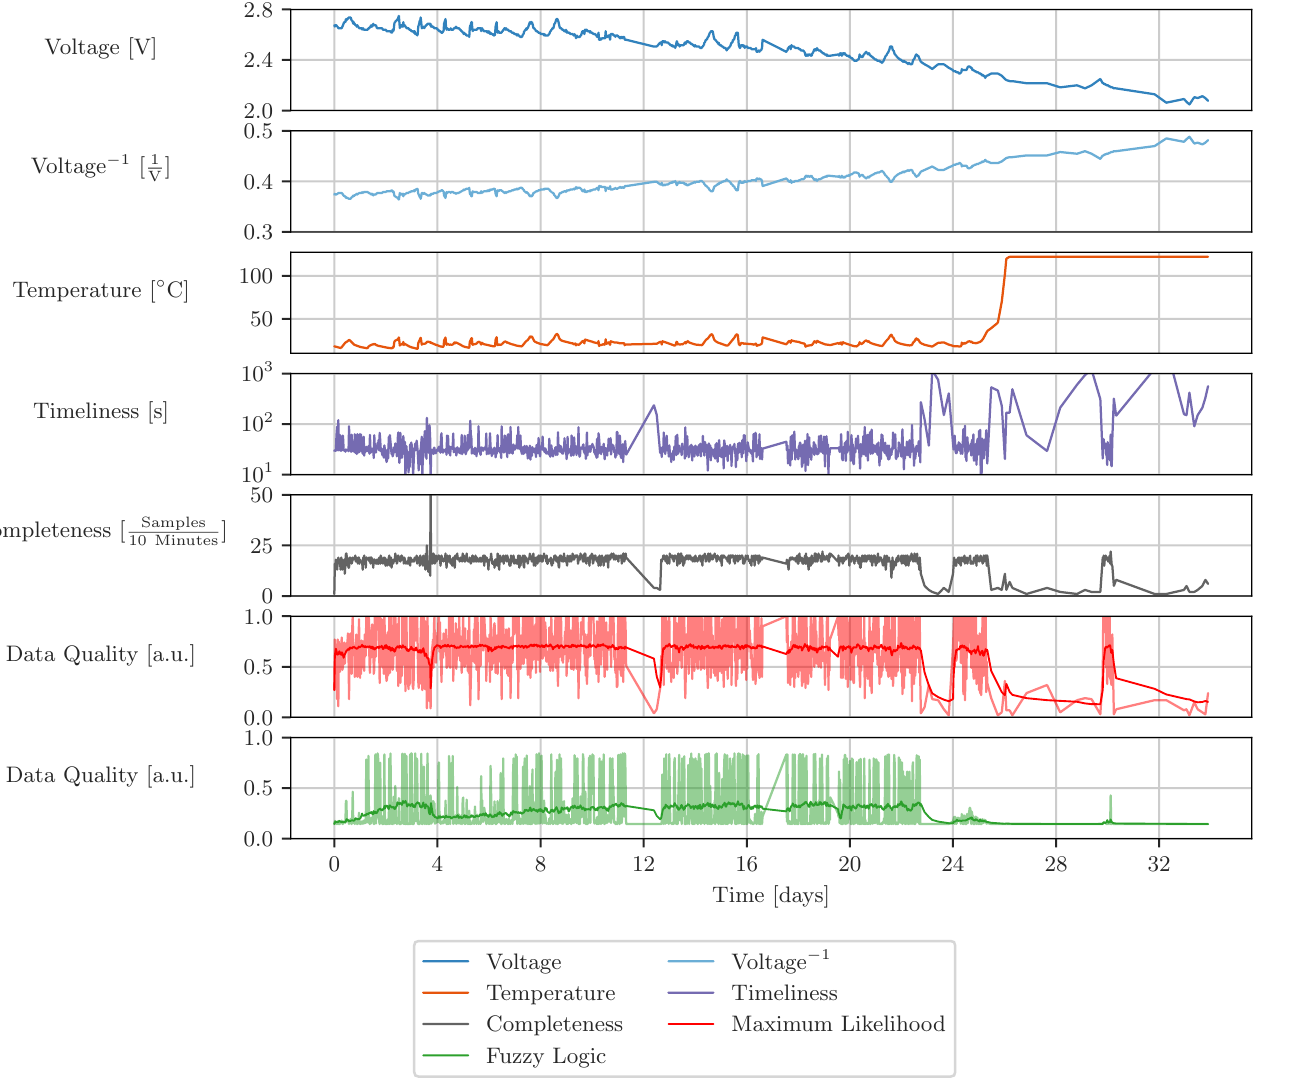
Figure A5. Intel Lab Data Mote ID 47, data quality attributes, measured values, and data quality